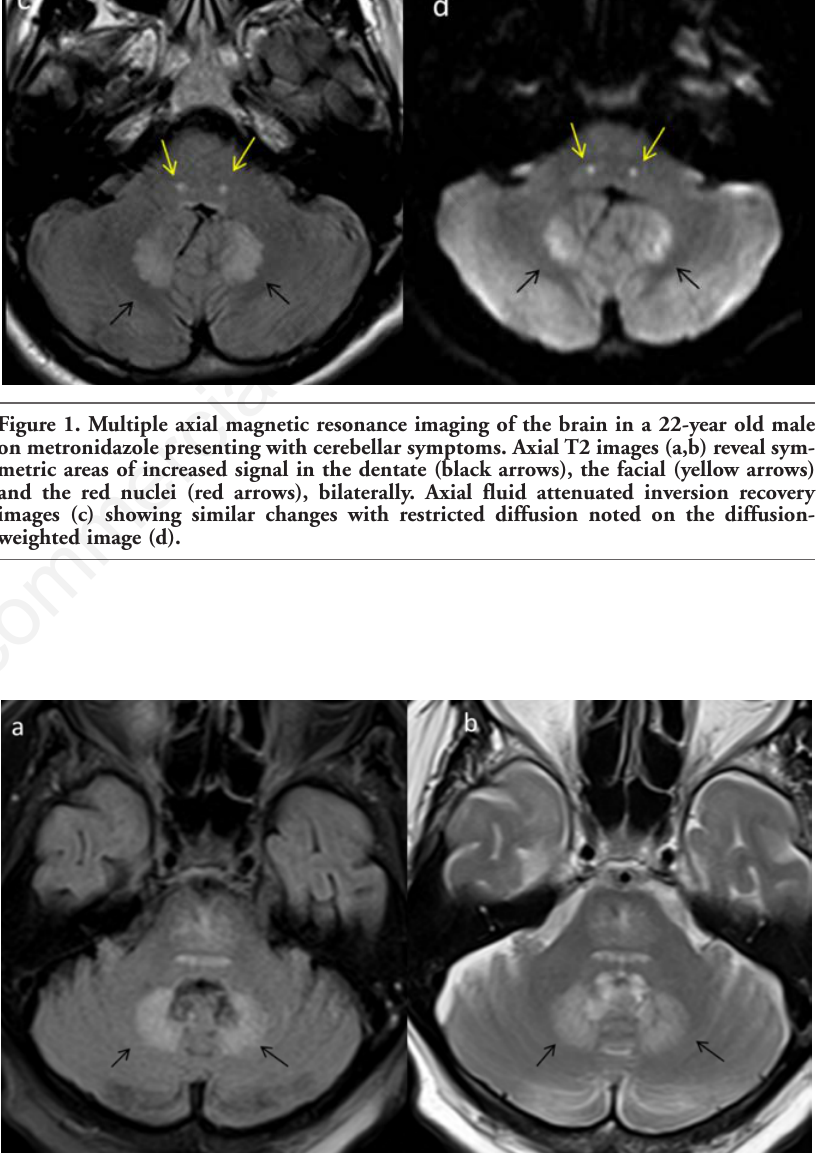
Figure 2. Axial fluid attenuated inversion recovery (a) and T2-weighted images (b) in an 80 year old lady on Metronidazole, presenting with ataxia and gait abnormalities. Symmetric areas of increased T2/fluid attenuated inversion recovery signal noted in the dentate nuclei, bilaterally (black arrows). Follow-up imaging was not performed as there was complete resolution of clinical signs and